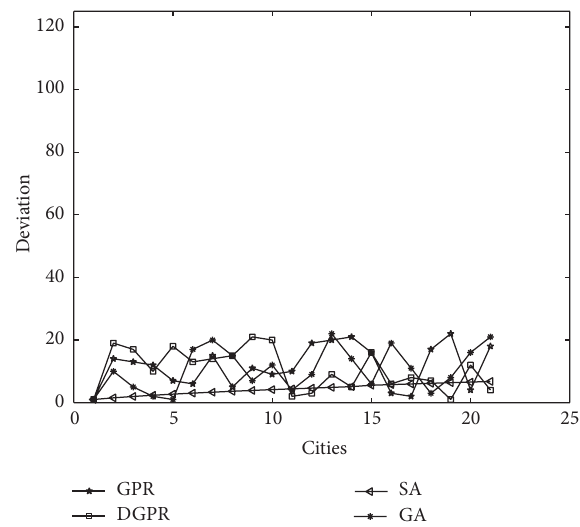
Figure 8: DGPR is juxtaposed with all other comparing methods in an instance of 22 cities for 200